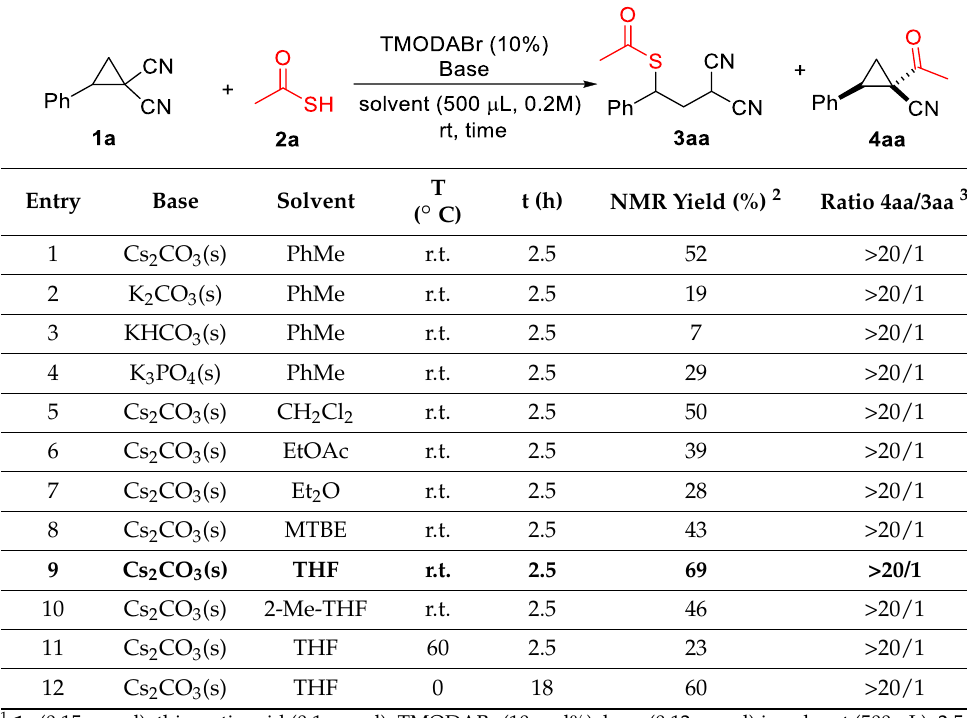
Table 2. Reaction condition screening 1 .